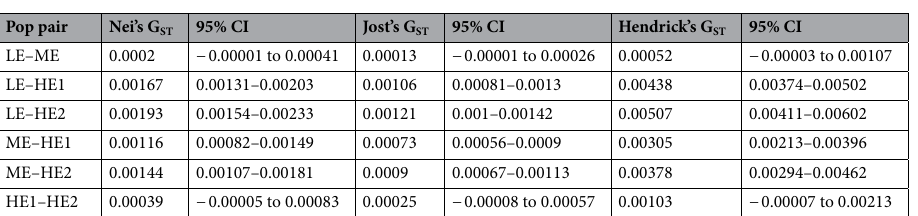
Table 3. Overall Nei’s G ST , Hedrick’s G ST and Jost’s D indices for each ecotypic group. Genetic differentiation is statistically significant if the lower bound of the CI was greater than zero. Note the HE ecotype is represented by two subplots (HE1 and HE2).